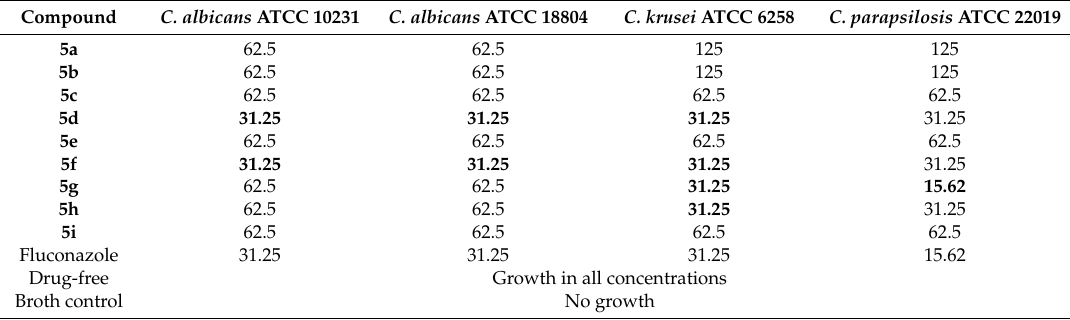
Table 2. The minimum fungicidal concentration values (MFC, µ g/mL) of the newly synthesized compounds 5a – i against all tested Candida